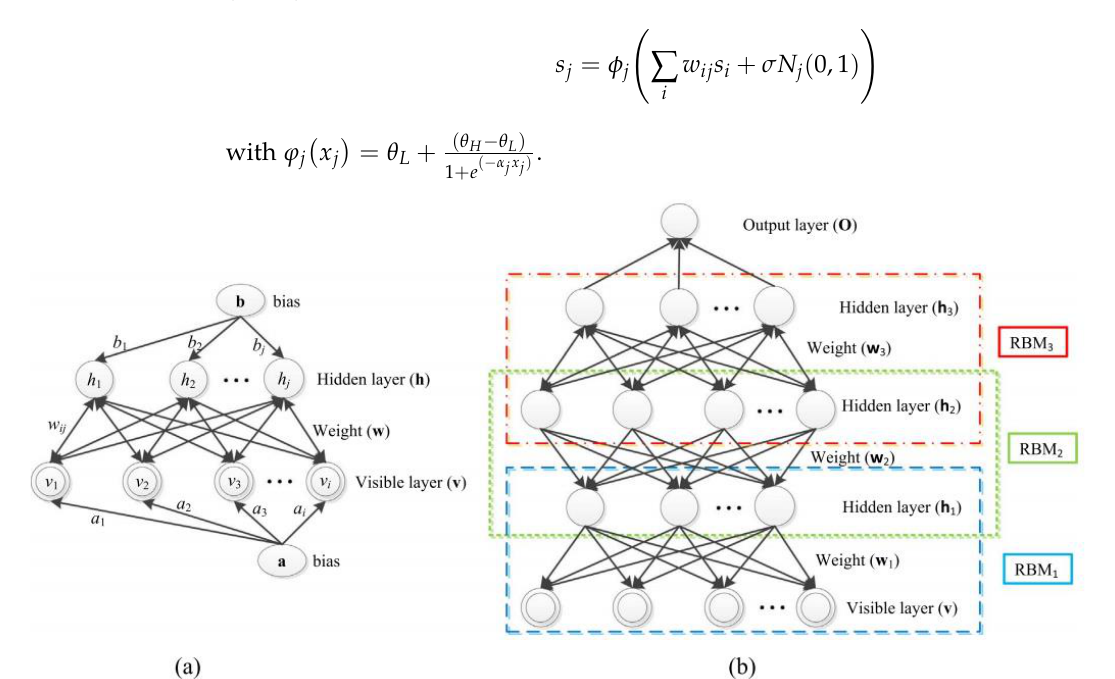
Figure 2. Network architectures: ( a ) an RBM and ( b ) a three-hidden-layer DBN.